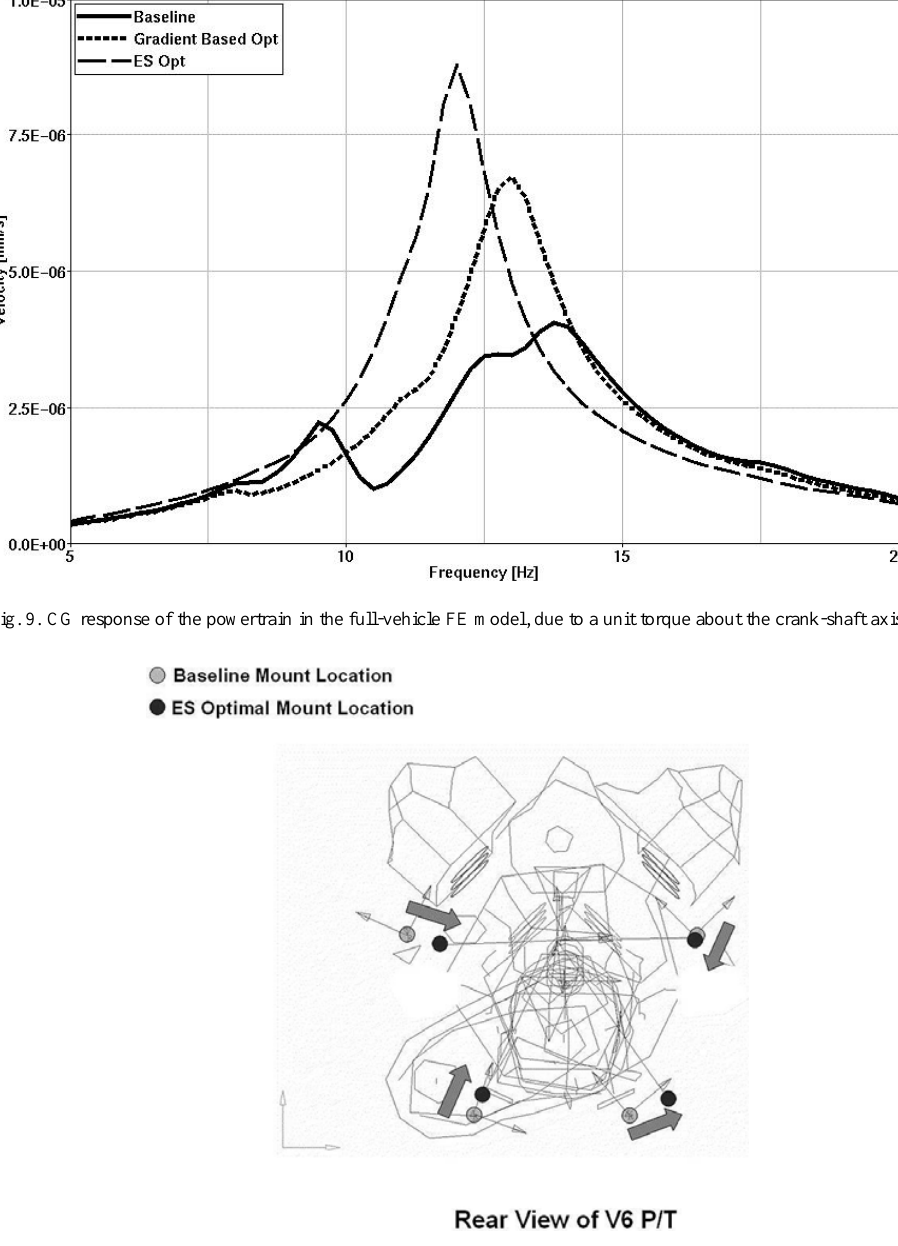
Fig. 10. ES optimized mount locations are compared with that of the baseline